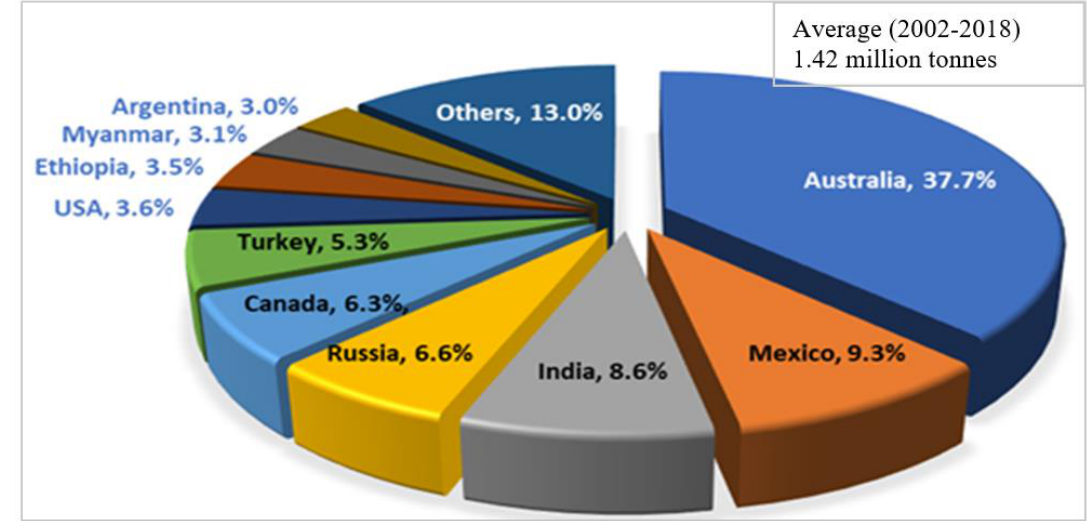
Figure 2. Major chickpea exporting countries (2000–2018) [4].